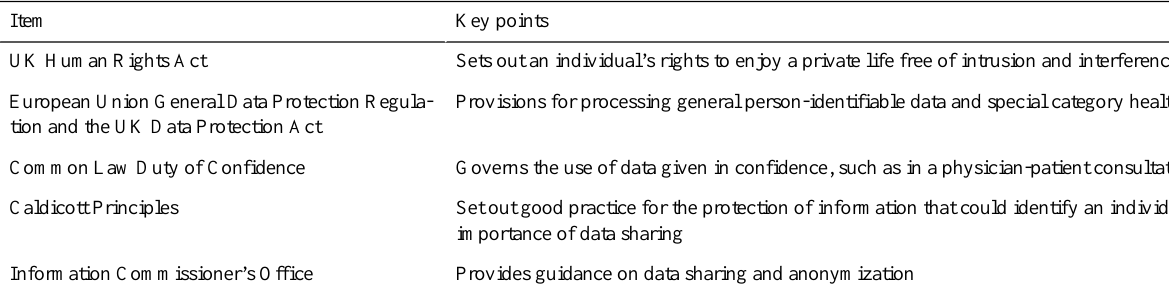
Table 1. Summary of relevant data protection landscape.